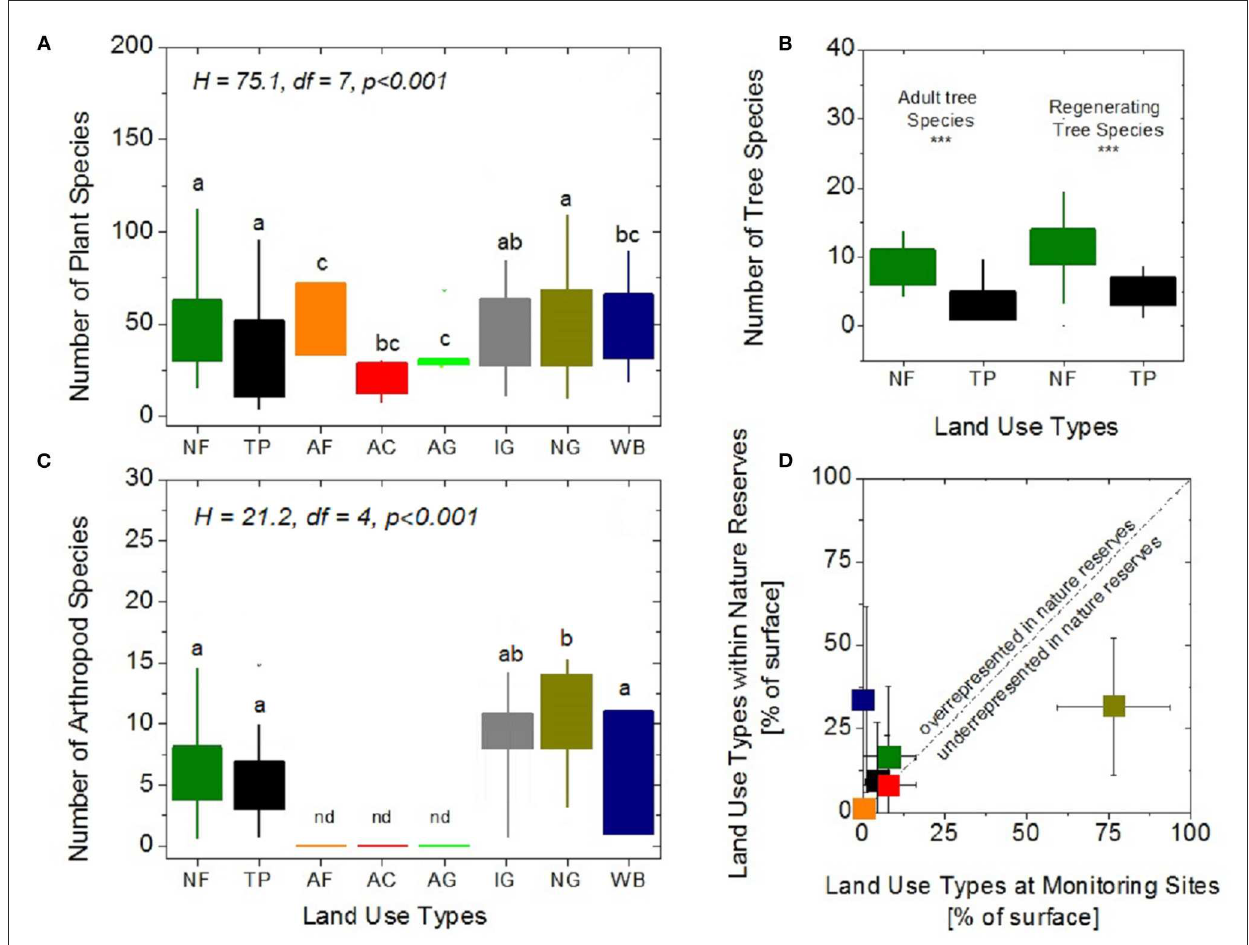
FIGURE6 Species richness of different land-uses in rural Uruguay. The main land-use types are natural (mostly gallery) forests (NF, dark green, N = 33), timber plantations (TP, black, N = 37), agroforestry ( Citrus and Vitis cultures, AF, orange, N = 3), agriculture (AC, red, N = 12); artificial pastures (AG, pink, N = 5), “improved pastures” by sowing legumes and by fertilization (IG, light green, N = 26); natural grasslands (“Campo natural”, NG, olive, N = 34), water bodies and others (WB, blue, N = 12). Species richness of plant species (A) and of terrestrial arthropods (C) . Different letters above the boxplot show significant differences between land-use types. The H, df and p values are given. (B) Number of tree species with adult individuals and number of regenerating species in natural forest versus timber plantations ( *** indicate a significance level p < 0.001). (D) Proportion of surface covered by different land-use types in nature reserve areas (MVOTMA, 2017) are plotted against the same proportion of different land-use types in the representative sample regions of the monitoring sites. Land uses above the diagonal line are overrepresented in the national reserves (e.g., water associated ecosystems (blue) and native forests (dark green), whereas natural grasslands (olive) are largely underrepresented or not